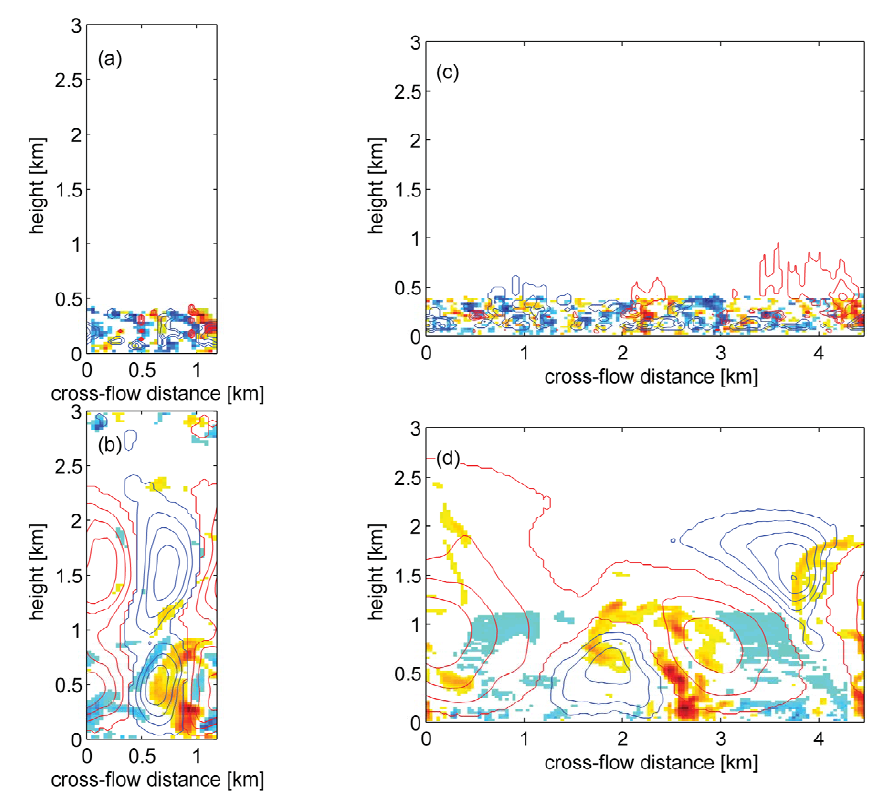
Fig. 12. Cross-flow sections ( yz planes) of the instant flow patterns in four LES runs: (a) WE U5L5 and (c) WE U5L90 in the small LES domain; (b) WE U5L90 and (d) WE U5L90 in the large LES domain. The panels are composed similarly to Fig.